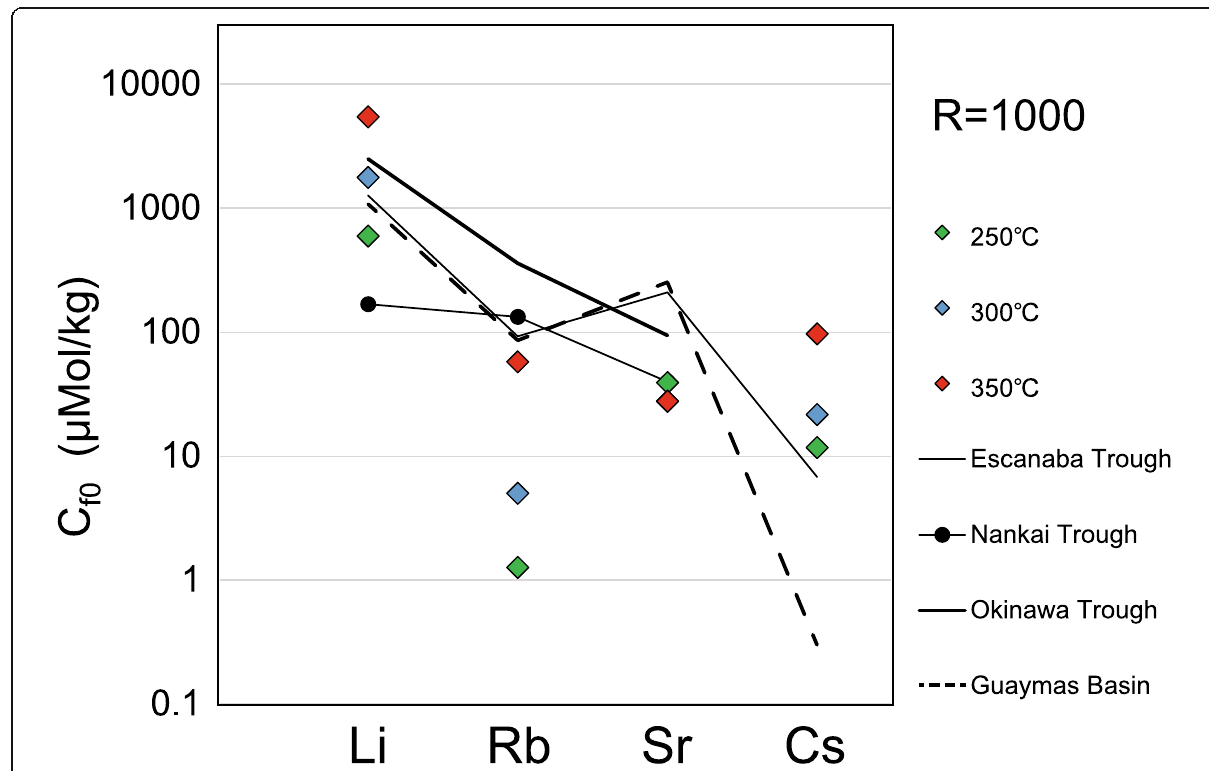
Fig. 9 Comparing with C f 0 value and modern pore fluids sampled from various settings. Vertical axis shows C f 0 values. Green, blue, and red diamond shows C f 0 values at temperatures of 250, 300, and 350 °C, respectively. Four black lines show concentrations of interstitial fluid at Mid- Atlantic Ridge (Campbell et al. 1988), Juan de Fuca Ridge (Butterfield et al. 1994), Escanaba Trough (Campbell et al. 1994), and Nankai Trough (Nishio et al. 2015),